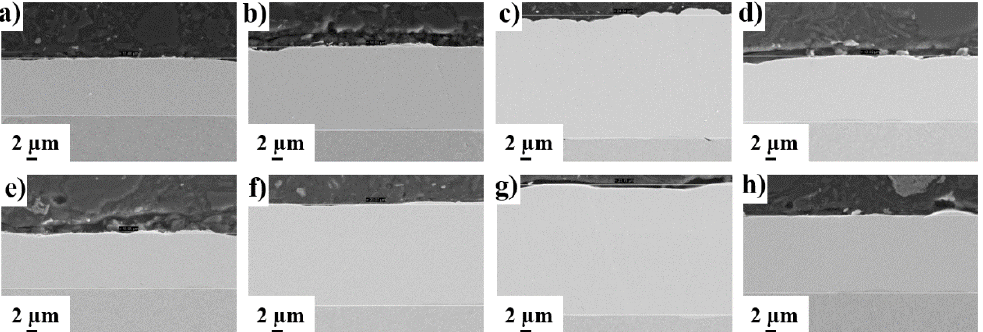
Figure 3. SEM images of the cross-section of ENP coatings obtained from experiment number ( a ) 1, ( b ) 2, ( c ) 3, ( d ) 4, ( e ) 5, ( f ) 6, ( g ) 7 and ( h ) 8.